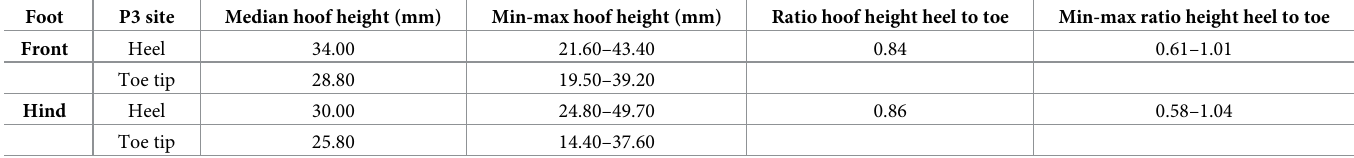
Table 3. Radiographs show that the hoof was consistently thicker at the heel relative to at the toe tip in free-ranging giraffe, resulting in a positive palmar/plantar angle. Sole heights were measured from the most palmar/plantar weight bearing surface of P3 (“heel”) and from the most distal weight-bearing surface of the P3 (“toe